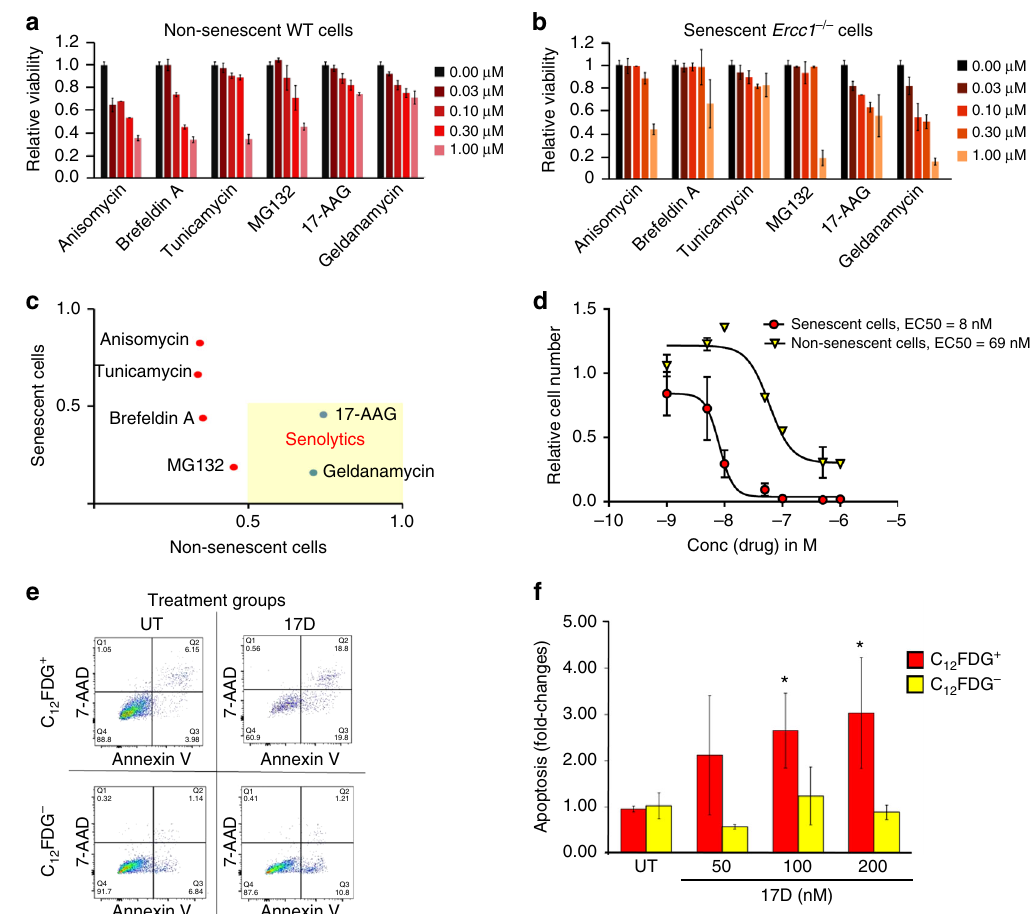
Fig. 5 HSP90 inhibitors selectively kill senescent cells. a , b Celltox Green cytotoxicity assay. All potential senolytic drugs were added to cultures of a non-senescent (con fl uent) wild-type and b senescent Ercc1 − / − primary MEFs at 4 concentrations (0.03 – 1.00 μ M). Error bars indicate SD for n = 3. c Graph depicting drugs that speci fi cally kill senescent cells. Plotted is the viability of non-senescent WT vs. senescent Ercc1 − / − cells after treatment with each drug for 48 h at a 1 μ M concentration. Cell toxicity was de fi ned as cell viability < 75%. Only cells that kill senescent cells, without signi fi cant toxicity to quiescent, non-senescent cells, are considered as senolytics (indicated in yellow shaded area ). d Dose response analysis of senolytic activity of 17-DMAG. Increasing concentrations of 17-DMAG (0.1 – 1000 nM) were tested and plotted against the fraction of remaining senescent ( red ) and non-senescent cells ( yellow ) after 48 h treatment. The EC 50 values of their senolytic potential were determined from their dose response curves using a 4-parameter curve fi t analysis (graphpad). Error bars indicate SD for n = 3. e Flow cytometric analysis of cell death of senescent Ercc1 − / − MEF cell cultures treated with 17-DMAG via AnnexinV/7-AAD staining. MEF cells are either senescent (C 12 FDG + ; Top) or non-senescent (C 12 FDG − , Bottom ). Live cells were double negative for 7-AAD and AnnexinV ( bottom left quadrant ), early apoptotic cells were positive for Annexin V ( bottom right quadrant ), late apoptotic cells were positive for AnnexinV and 7-AAD ( top left quadrant ) and dead cells were positive for 7-AAD only ( bottom right quadrant ). f Quanti fi cation of the fl ow cytometry data. Apoptosis of senescent ( red ) and non-senescent ( yellow ) cells was calculated by summing up all AnnexinV-positive cells. Error bars indicate SD for n = 3, * p < 0.05, two-tailed Student ’ s t